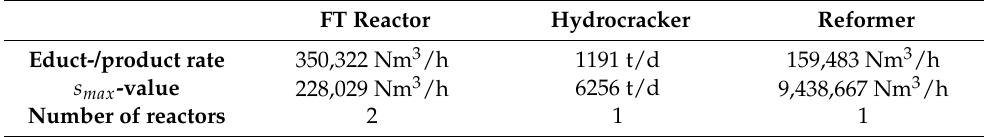
Table A4. Capacities of the Fischer–Tropsch reactor, the hydrocracker and the